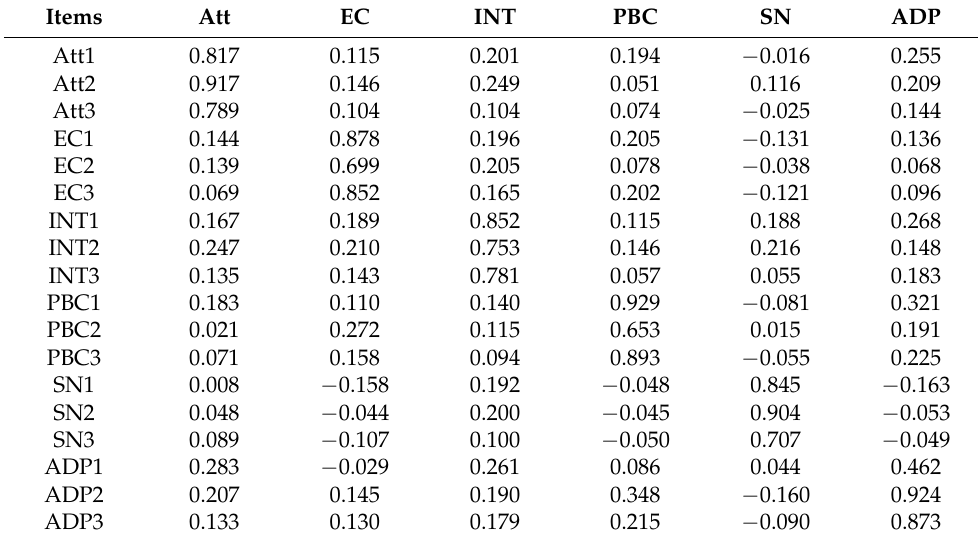
Table 4. Cross-loadings of the outer